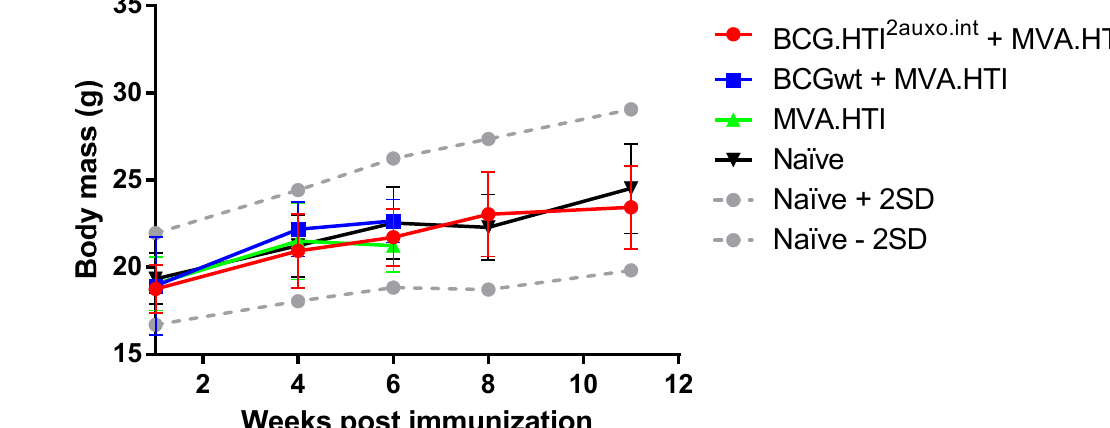
Figure 4. Safety of the BCG.HTI 2auxo.int and MVA.HTI prime-boost regimen in BALB / c mice. Mice in groups of five (female, 7-weeks old) were immunized intradermally with 10 6 CFU of BCG.HTI 2auxo.int or BCGwt and boosted with 10 6 pfu of MVA.HTI (im). Body weights were recorded regularly, and the mean for each group of mice is shown as mean ± SD ( n = 5). Data from naive mice are presented as mean ± 2 SD ( n = 5) (dashed grey lines).